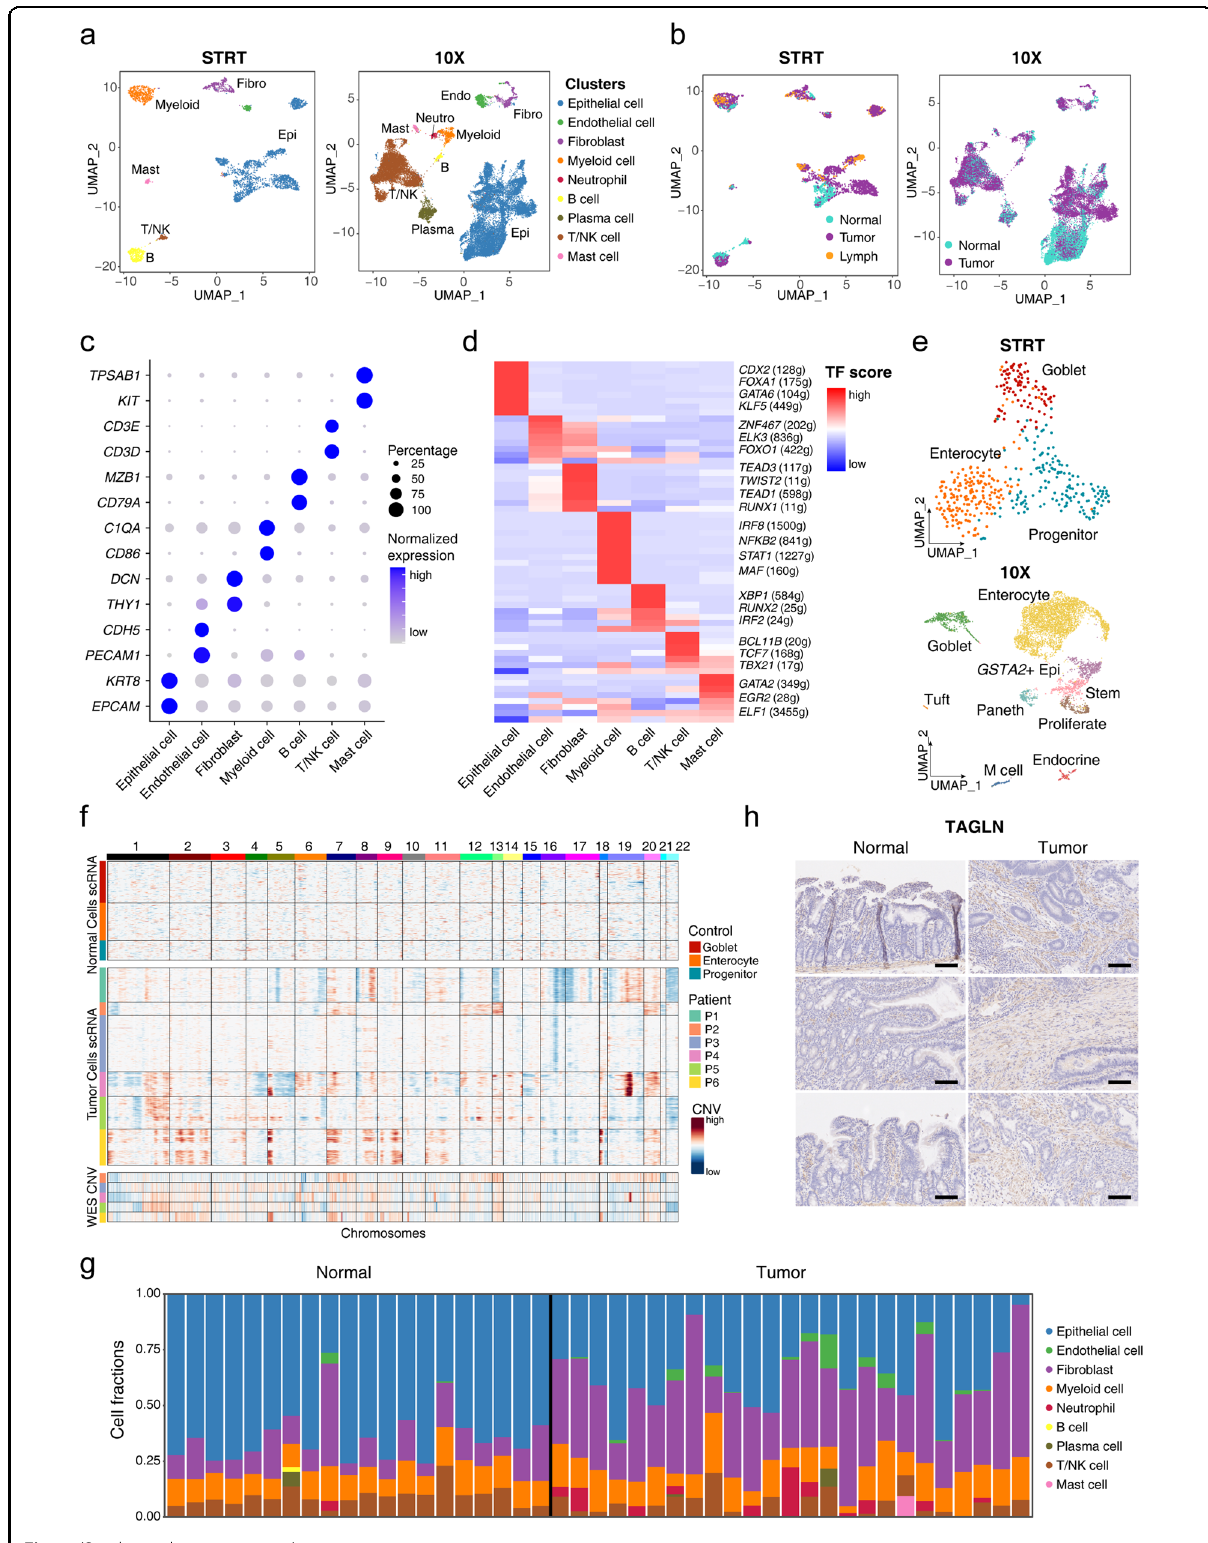
Fig. 1 (See legend on next